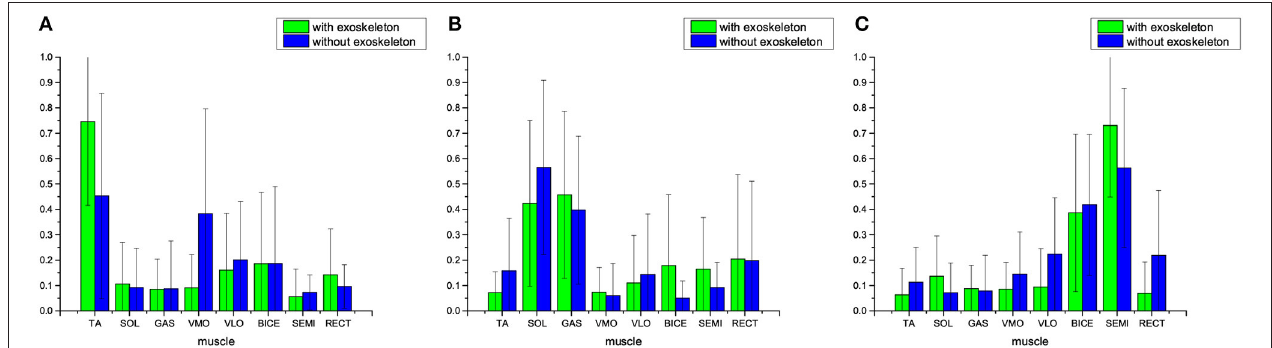
FIGURE 3 | Average muscle synergies of the 17 subjects who walk with and without lower-limb exoskeletons. NMF is used to exact the muscle synergy with reduced dimension being k = 3. (A) Synergy 1, (B) Synergy 2, and (C) Synergy 3.